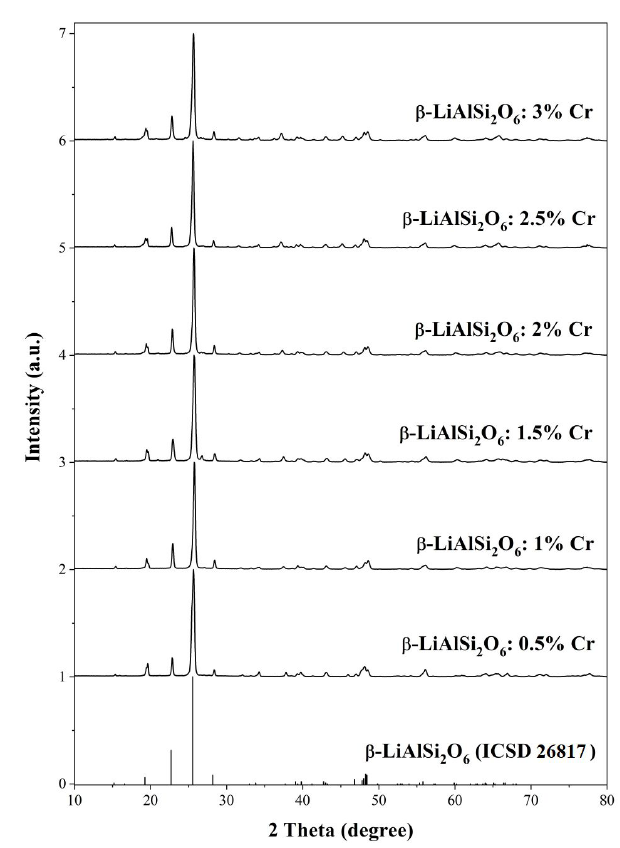
O :Cr and the standard reference ICSD 2 6